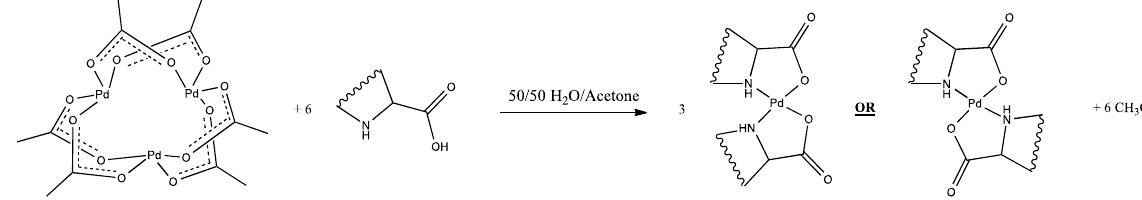
Figure 2. General reaction scheme for the synthesis of cis and trans palladium(II) proline/cyclic complexes.